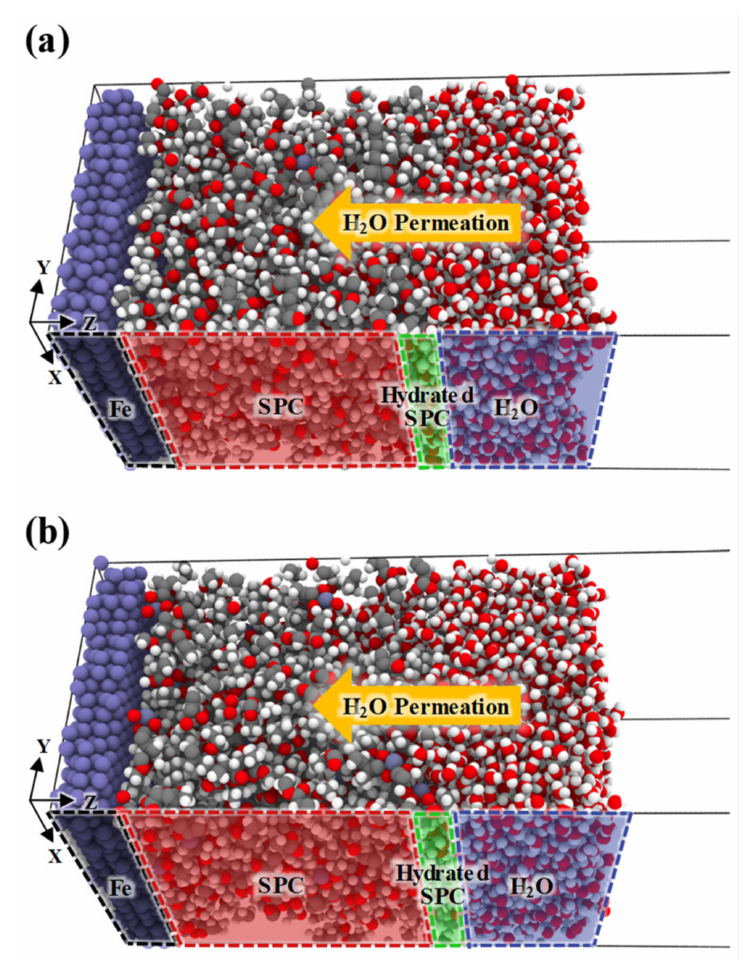
Figure 3. Initial equilibrated structures of ( a ) Z2 and ( b ) Z16 SPCs with H 2 O molecules on Fe slabs. White, gray, red, navy blue, and dark purple correspond to hydrogen, carbon, oxygen, zinc, and iron,